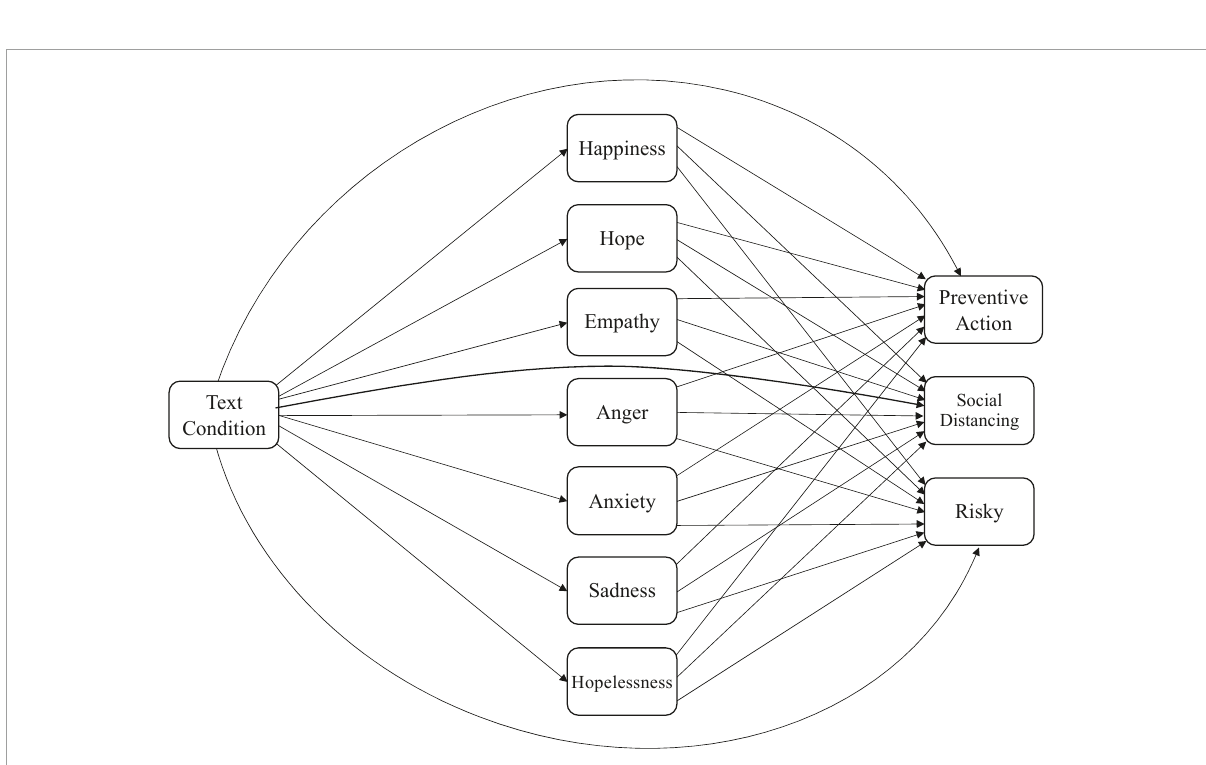
FIGURE2 Hypothesized model of relations between text condition, emotions, and actual engagement in preventive